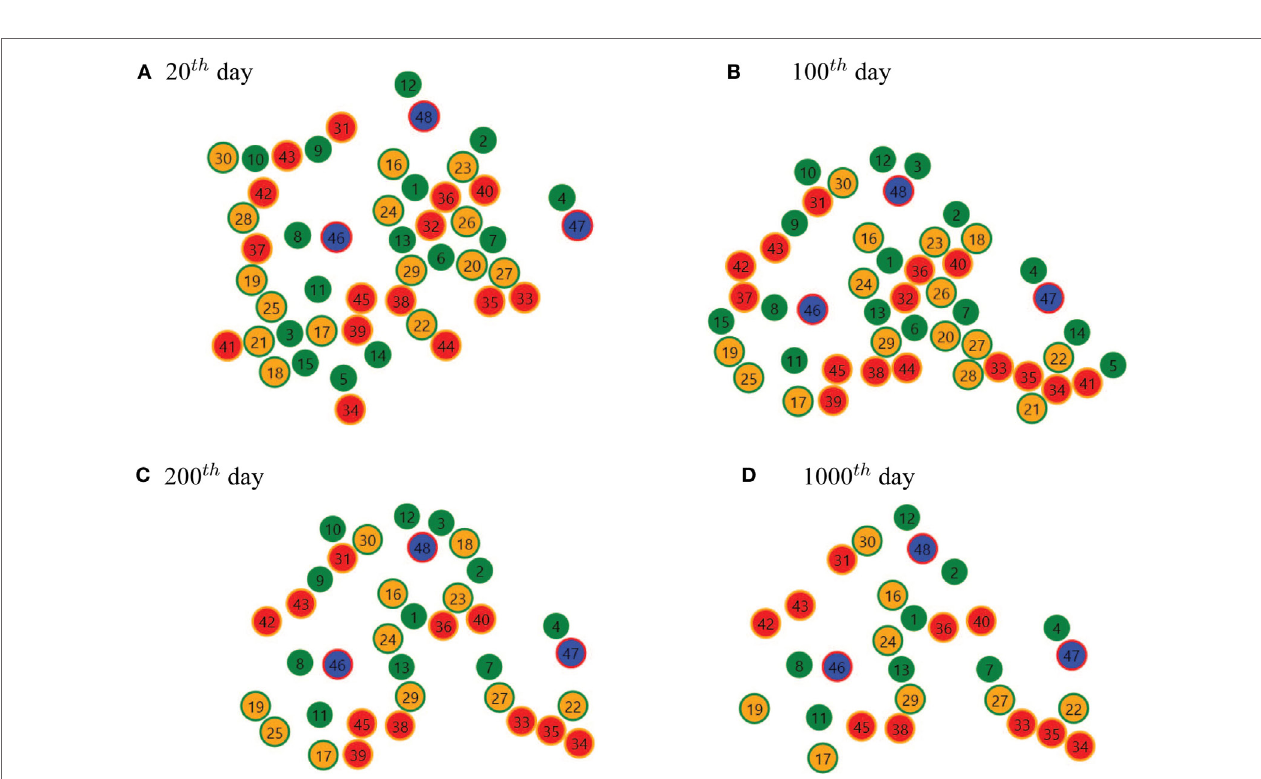
FigUre 13 | example of stable agent arrangements in time: (a) On the 20th day, (B) on the 100th day, (c) on the 200th day, and (D) on the 1000th day .